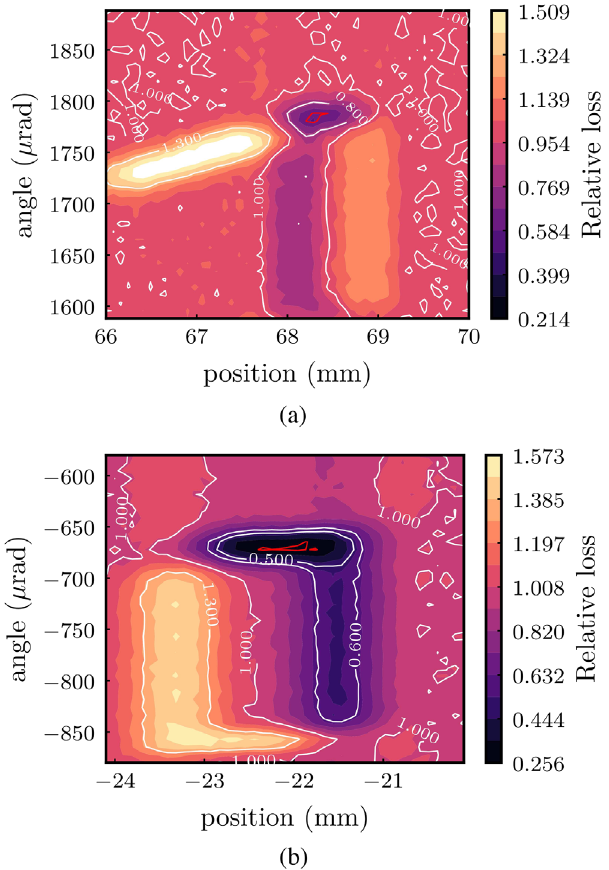
FIG. 11. Relative beam loss during extraction for the two scenarios studied in simulation: a local crystal in LSS2 and a nonlocal crystal in LSS4. For this scans the ES effective thickness has been assumed of 500 μ m and being angularly aligned with the separatrix. (a) Local shadowing of the ES with a bent crystal: 0.8 mm thick and with 174 μ rad deflection in channelling. The red contour represents loss reduction of 40% with respect to normal slow extraction losses (no crystal). (b) Non-local shad- owing of the ES with a bent crystal: 1.8 mm thick and with 174 μ rad deflection in channelling. The red contour represents loss reduction of 75% with respect to normal slow extraction losses (no